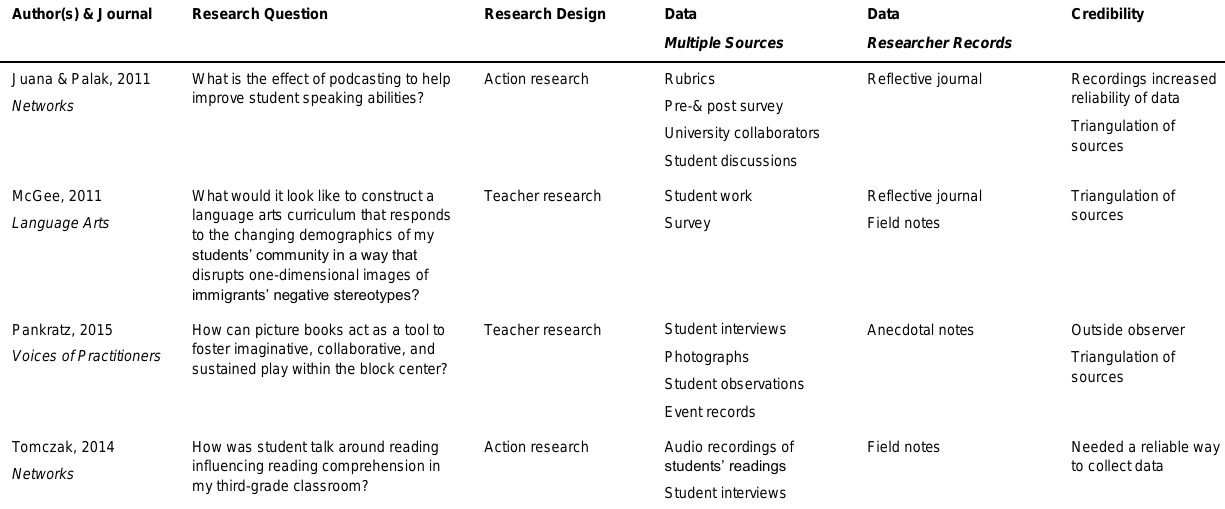
Table 2. Exemplars of Practitioner